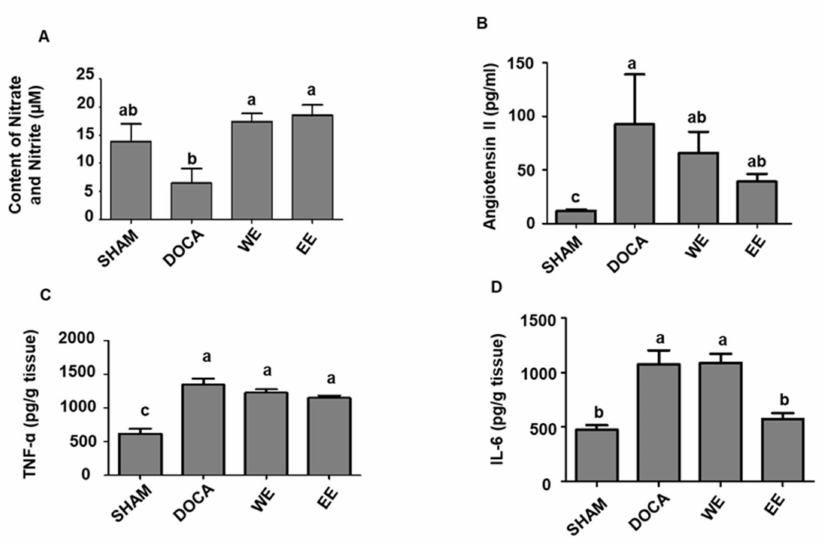
Figure 4. Effects of the water extract and ethanol extract of L. rhamnosus AC1-fermented soymilk on the NO content ( A ), levels of angiotensin II ( B ), TNF- α ( C ) and IL-6 ( D ) in the DOCA-salt hypertensive rats. Data are presented as means ± SEM ( n = 6). Bar values bearing different letters were significantly different by Duncan’s multiple range test ( p <